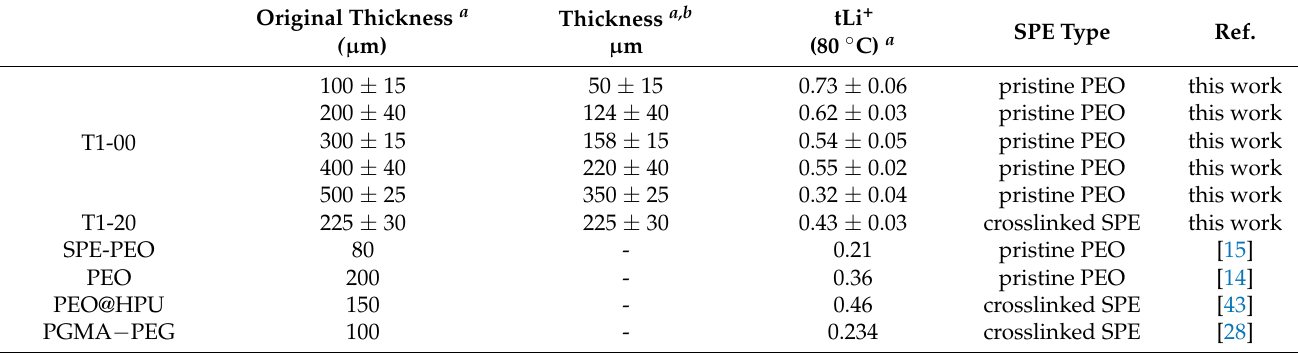
Table 1. Thickness-dependent lithium ion transference numbers (tLi + ) of